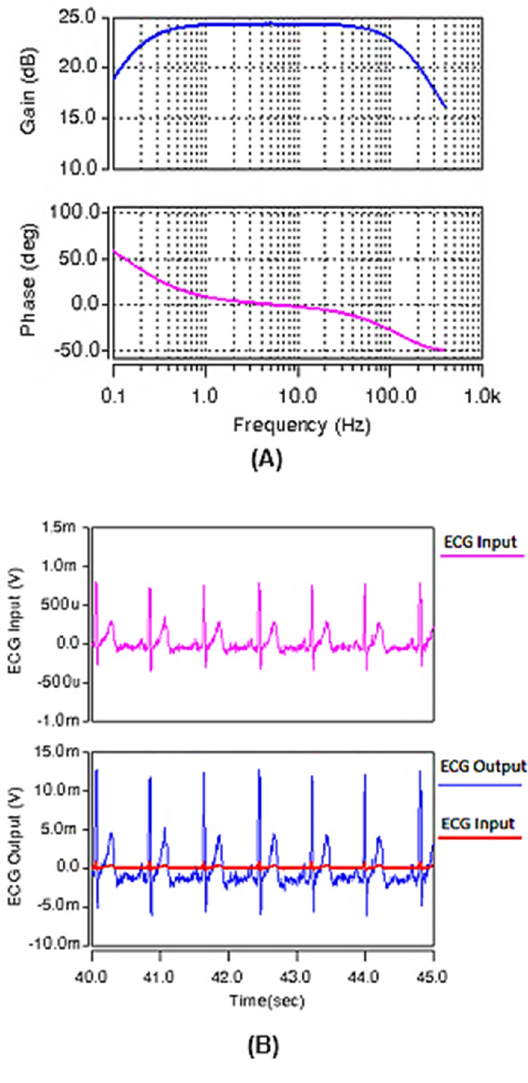
Figure 11. ( A ) The frequency response of the gain and phase of the band-pass amplifier for ECG recording. ( B ) The ECG input and its related output signal after amplification and filtering using the designed circuit of Figure 8.